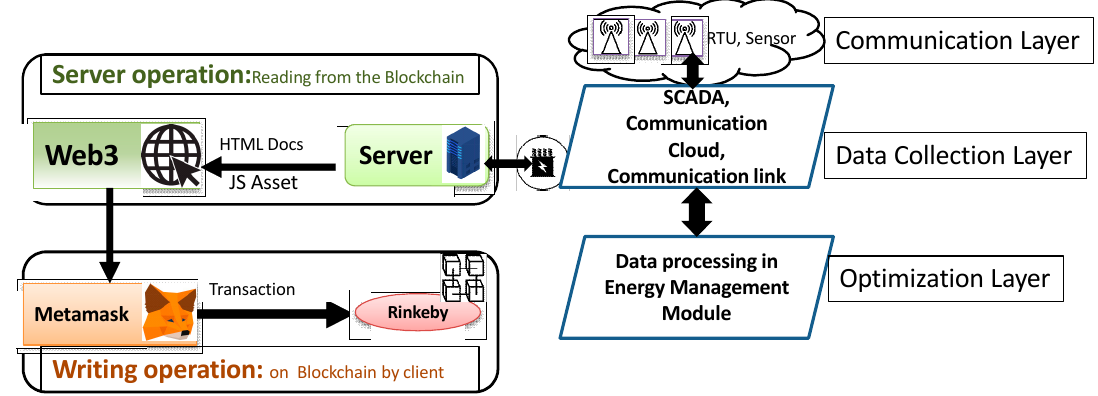
Figure 4. The Construction flowchart of Smart Contract.